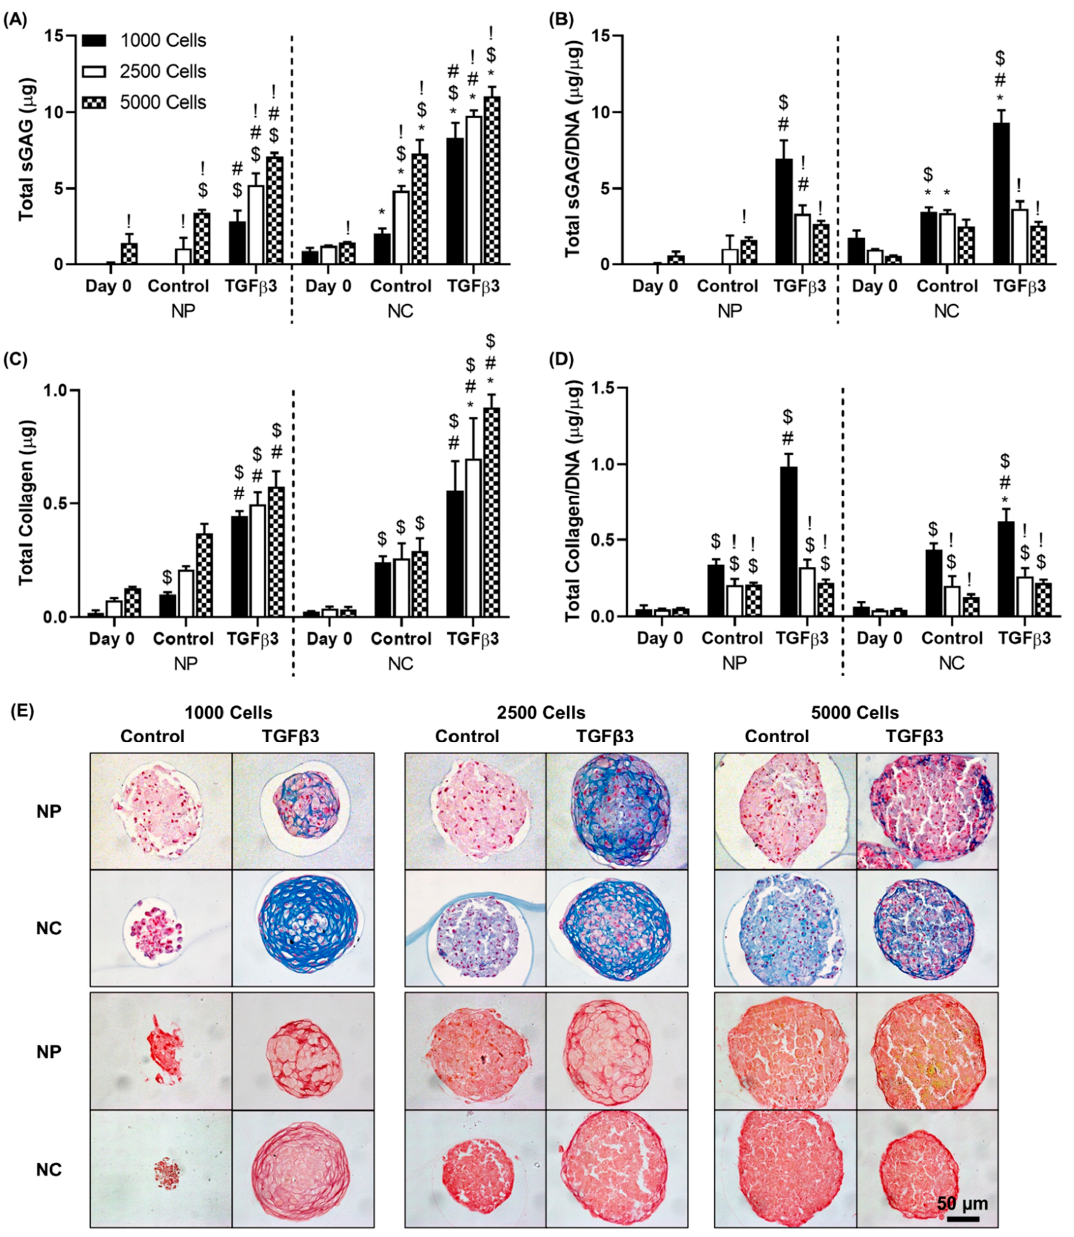
Figure 3. Biochemical and histological staining for sGAG and collagen of nucleus pulposus (NP) and nasoseptal chondrocyte (NC) microtissues stimulated with TGF β 3 on day 7. ( A ) Total sGAG ( μ g) content ( B ) Total sGAG/DNA ( C ) Total Collagen ( μ g) ( D ) Total Collagen/DNA. Data represent mean ± SD of at least three independent experiments performed in triplicate. ! ( p < 0.05) indicates significance compared to 1000 cells/microtissue. # ( p < 0.05) indicates significance compared to the control for the same cell number on day 7. $ ( p < 0.05) indicates significance compared to day 0 for the same cell number. * ( p < 0.05) indicates significance compared to the NP microtissues for the same experimental group and cell number. ( E ) Histological evaluation with alcian blue staining and picrosirius red to identify sGAG collagen content, respectively.